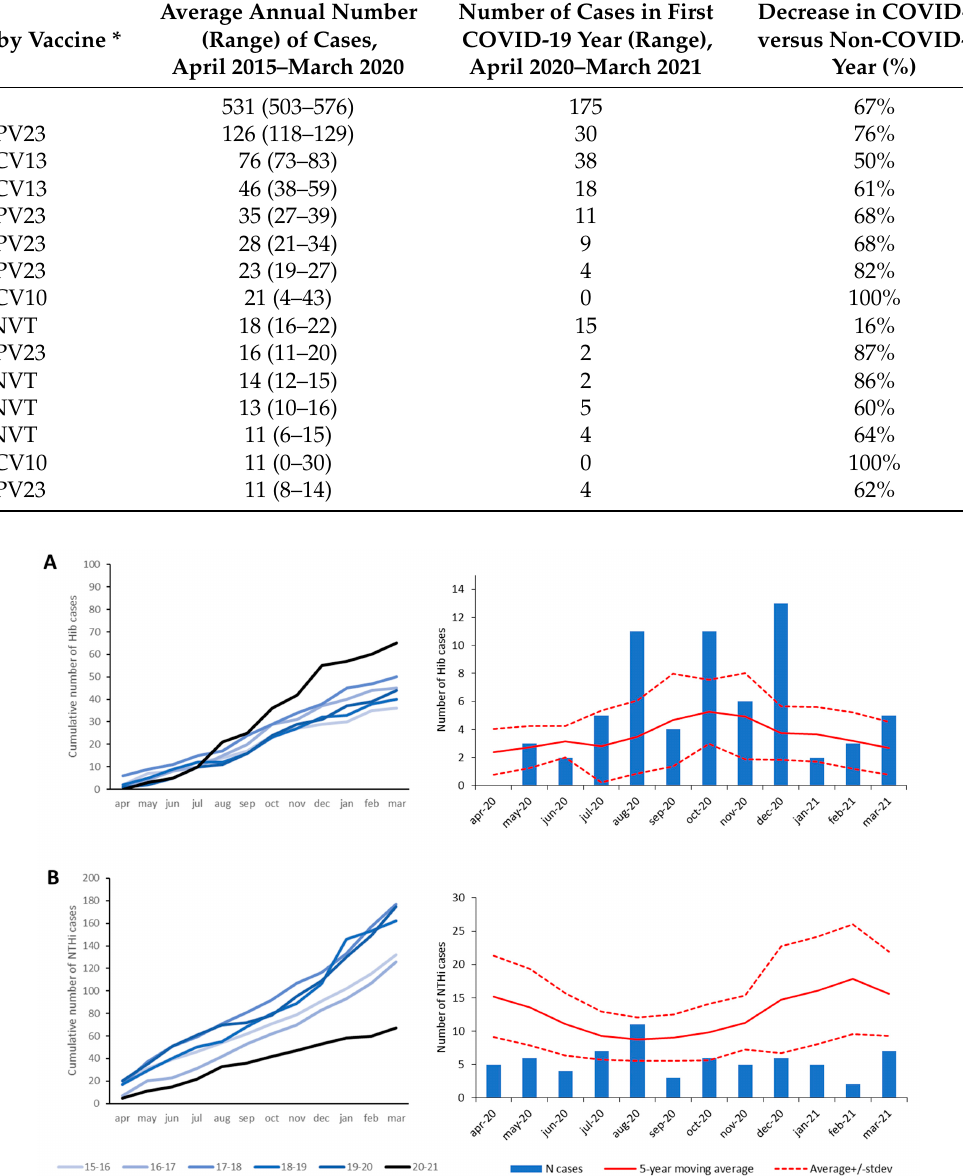
Figure 4. Cumulative number of cases (left) and monthly number of cases (right) for the first COVID-19 year (bars) compared to the 5-year moving average in pre-COVID-19 years (solid line) and the moving average plus/minus its standard deviation for the pre-COVID-19 period (dashed line) for ( A ): Haemophilus influenzae serotype b (Hib); and ( B ): non-typeable H. influenzae (NTHi).